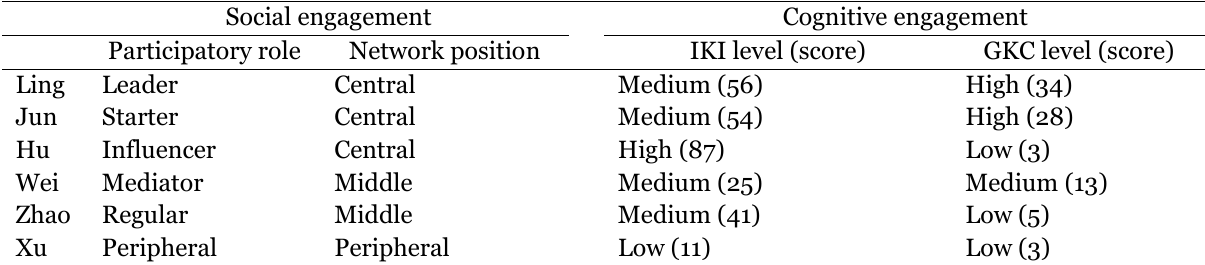
Pattern Results